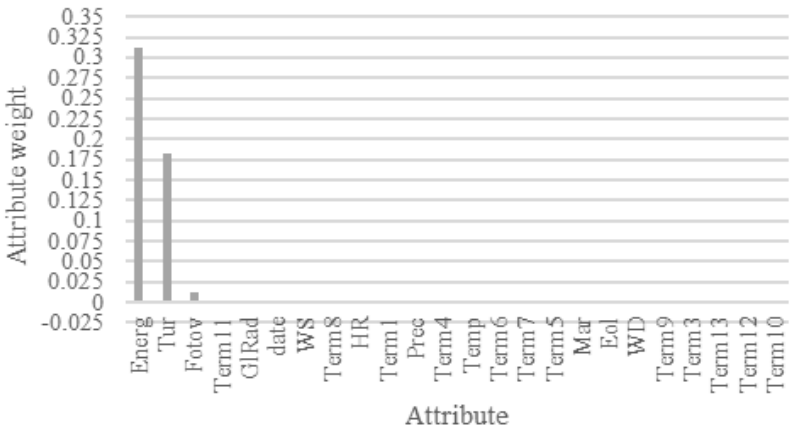
Figure 6. Importance of Jrip attribute vs. attributes.